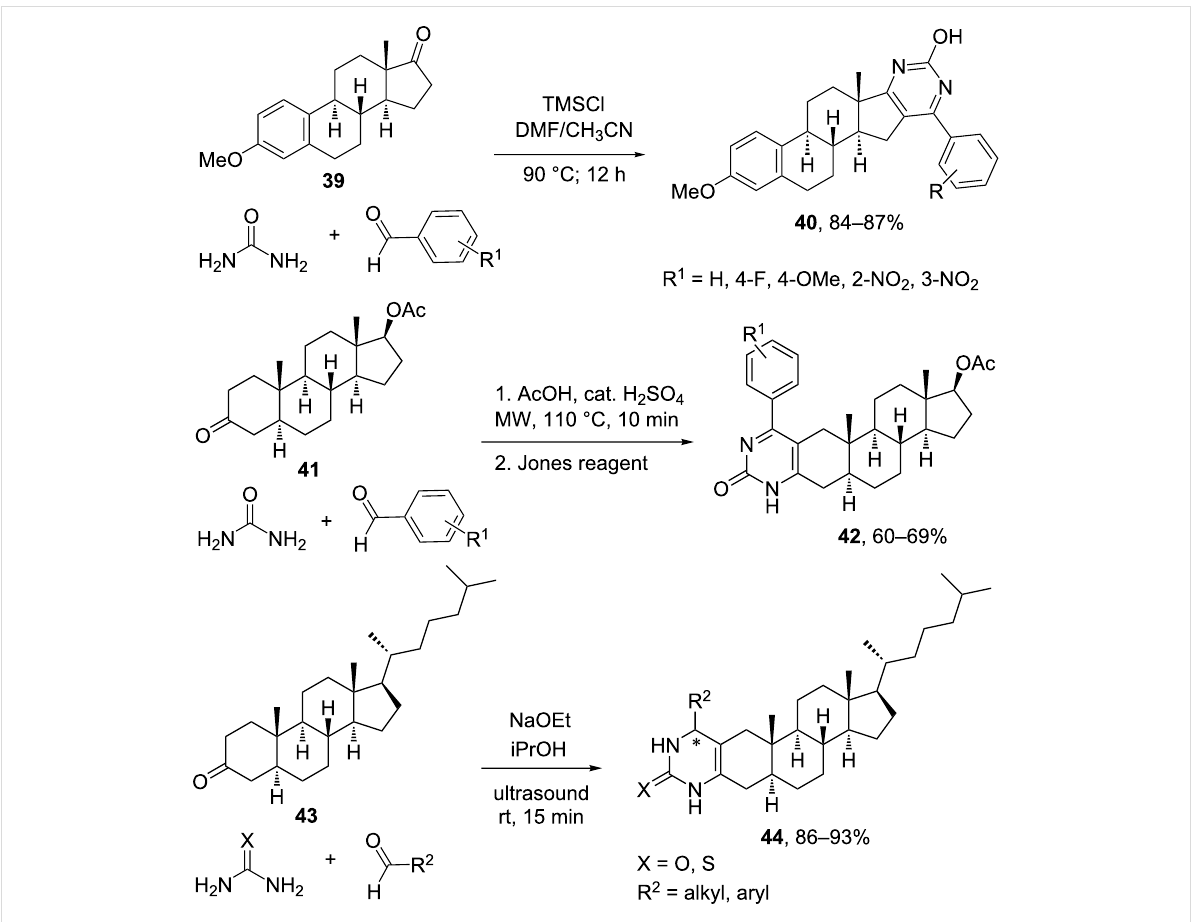
Scheme 13: Synthesis of steroid-fused pyrimidines and pyrimidones using the Biginelli-3CR [39,42,43].